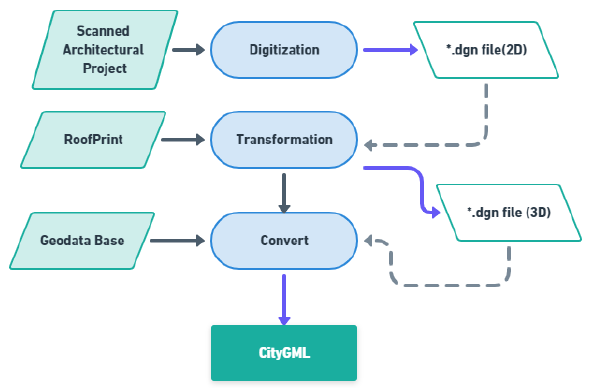
Figure 3. Workflow of GML